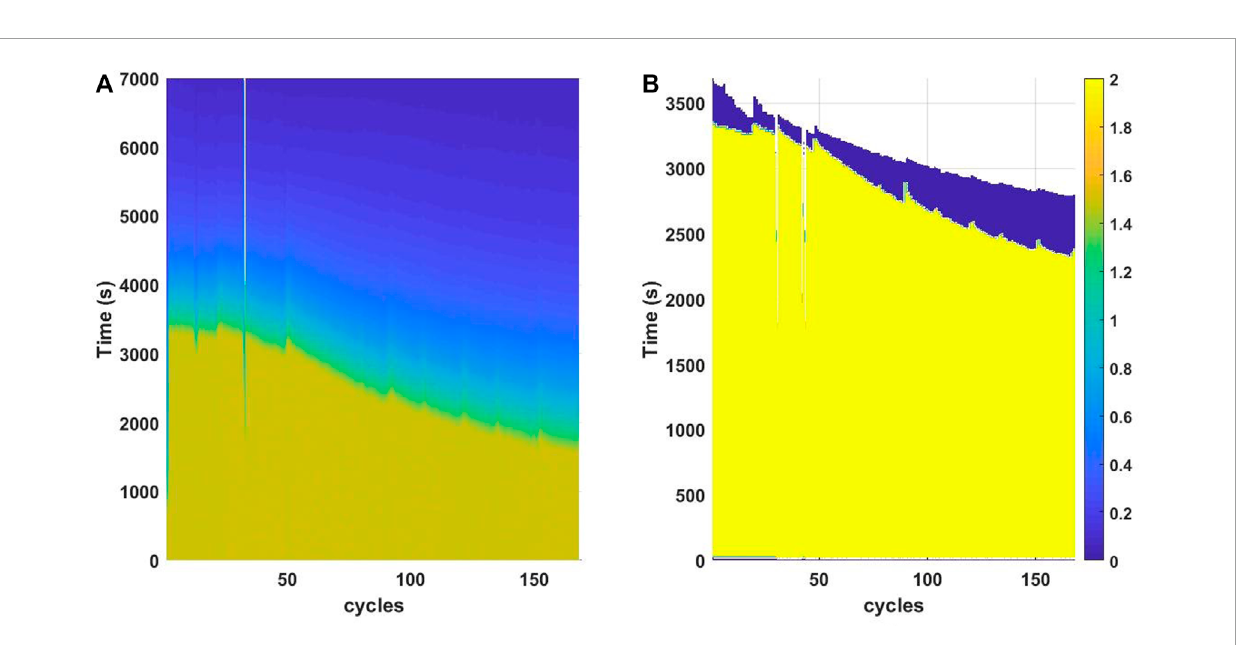
Minimum Discharging Voltage time: During the discharging process, the time for which the battery terminal voltage reaches its minimum voltage is given